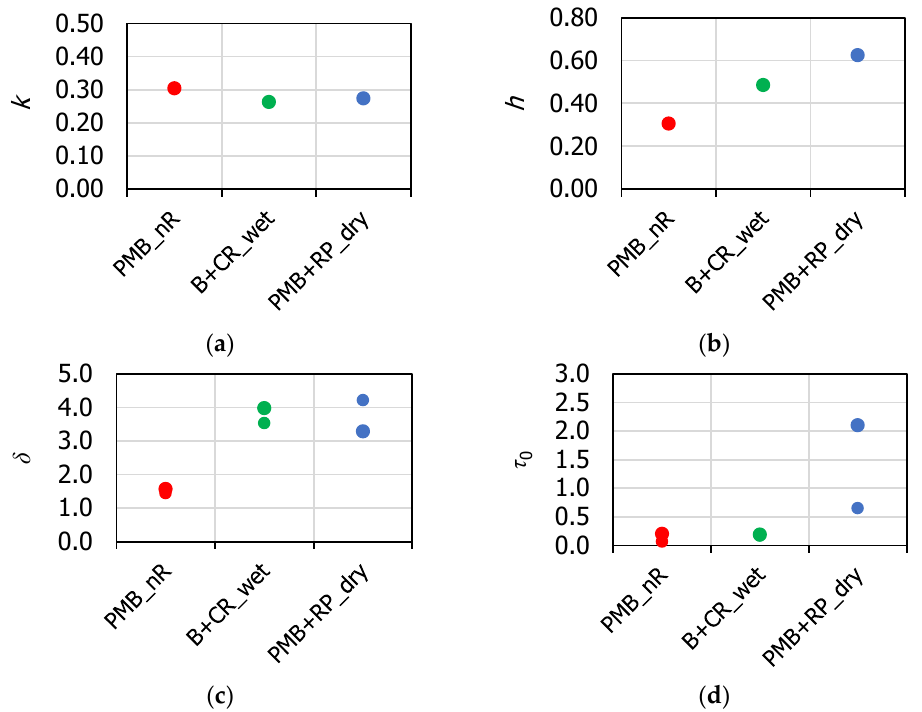
Figure 6. Analysis of HS model parameters: ( a ) k ; ( b ) h ; ( c ) δ ; ( d ) τ 0 .